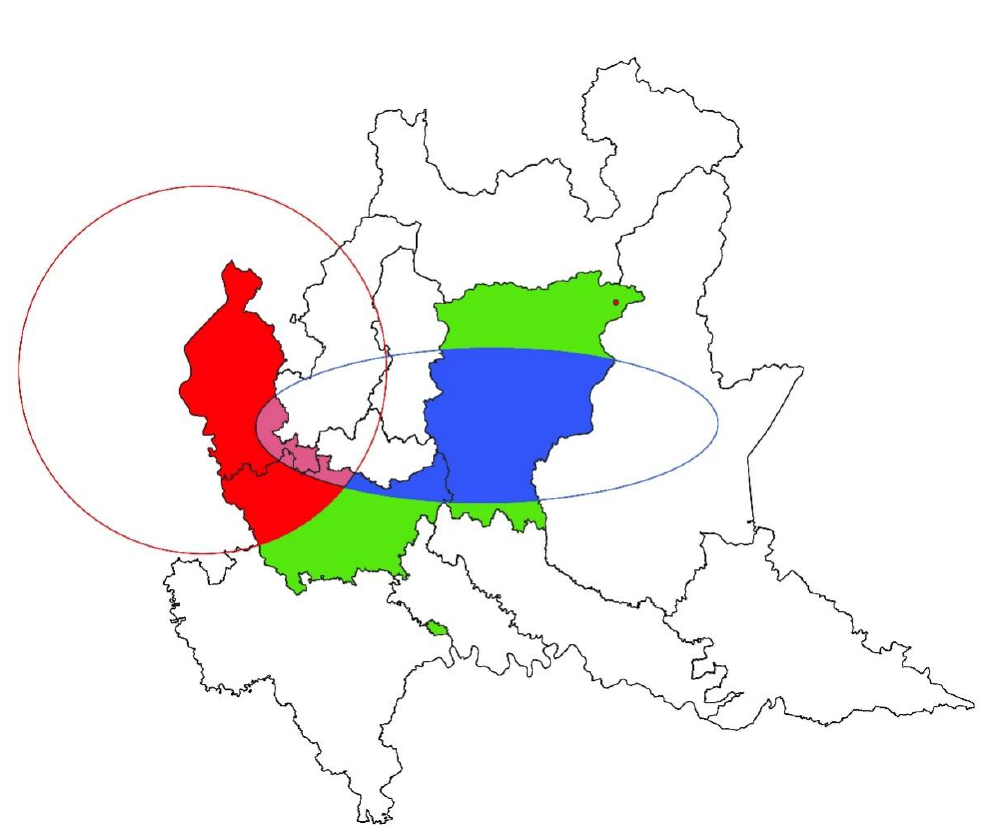
Figure 3. Geographical allocation of significant clusters of Neospora caninum infections in sheep farms in northern Italy. Red represents the cluster of high prevalence of infection, blue represents the cluster of low prevalence of infection, and green represents the studied area (Varese, Milano, and Bergamo provinces).